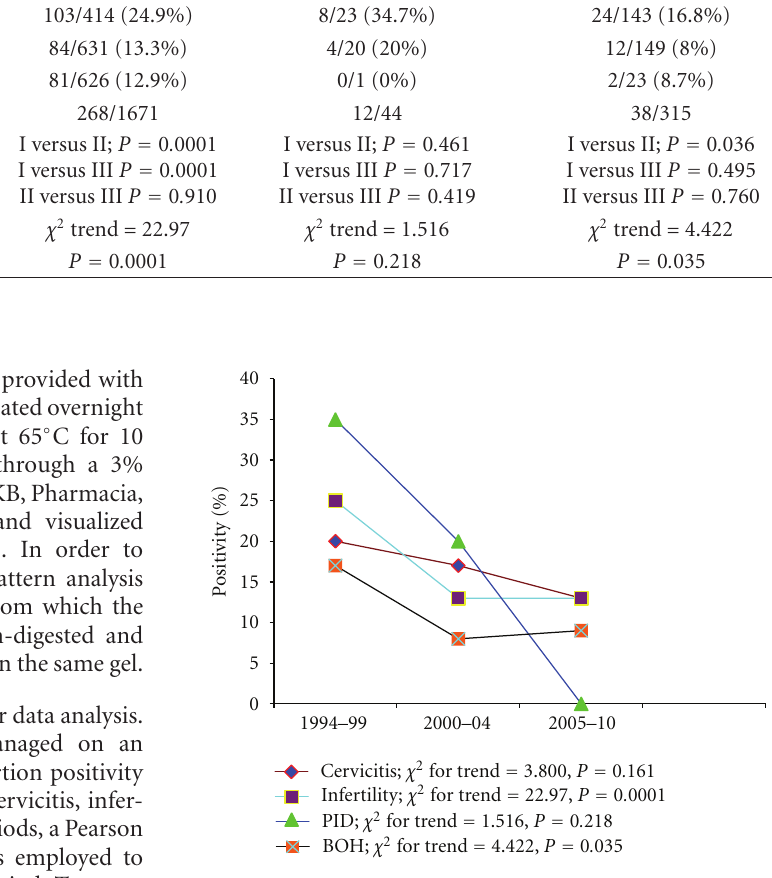
Figure 1: Yearwise positivity rates of Chlamydial infections (based on DFA test results) amongst various disease